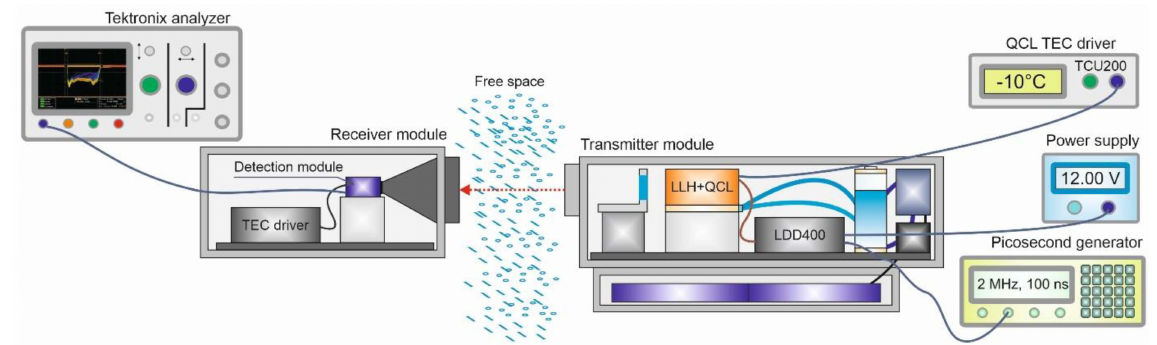
Figure 10. The scheme of the measurement of the FSO link in the real conditions.